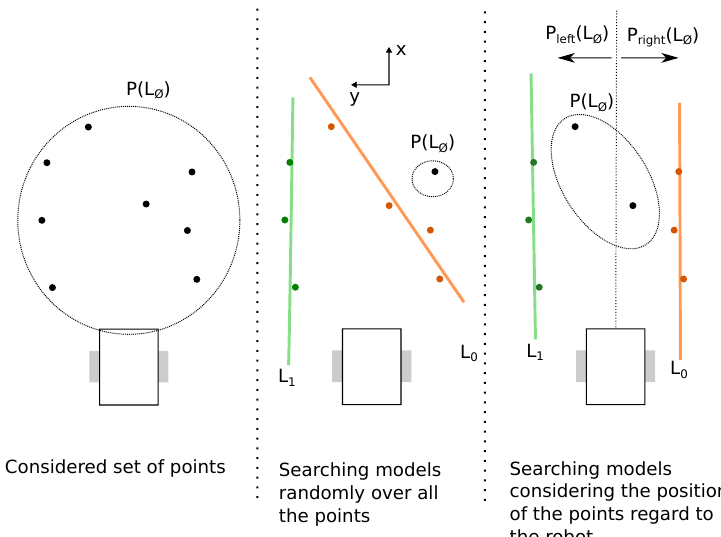
Figure 4. The idea behind considering P left ( L ∅ ) and P right ( L ∅ ) . Without doing so, there is a chance that the model research considers improbable models regarding the orientation of the robot (middle part of the illustration), reducing the chance of finding the best models . On the other hand, while dividing the model research into left and right points, as the rows should be on the left or on the right, the chances of finding the correct models are increased (the right section of the